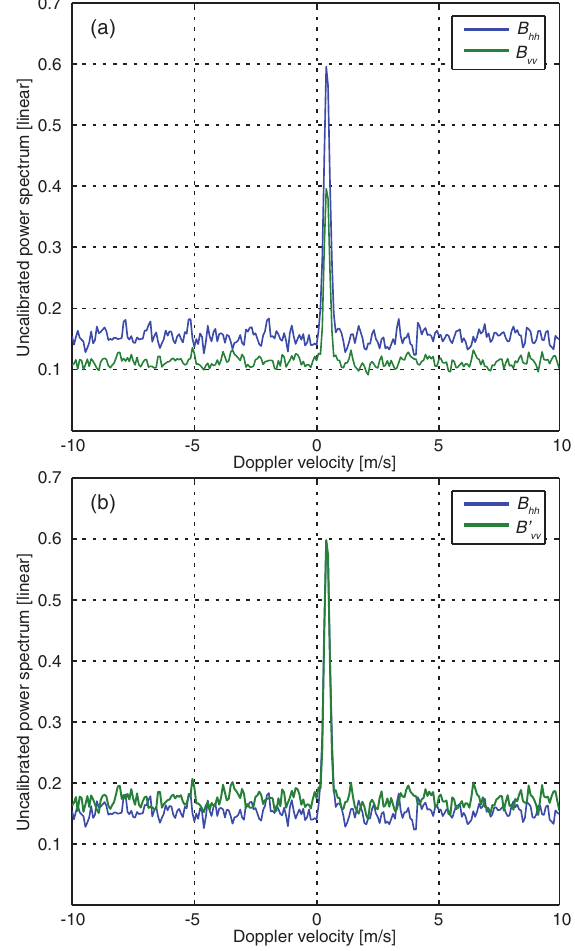
Figure 4. (a) Uncalibrated power spectra in the horizontal (blue line) and vertical (green line) channels. Displayed observations were obtained with the vertically pointed radar in light rain. (b) Un- calibrated power spectrum in the horizontal channel (blue line) and corrected power spectrum in the vertical channel (green line). The same data as in (a) are used. Mean noise levels of B hh and B (cid:48) vv , estimated using the Hildebrand–Sekhon algorithm, are 0.153 and 0.169, respectively. Note that this case was chosen to illustrate the correction. Due to low signal-to-noise ratios, such spectra were not used for the calculation of the coefficient K a (see Sect. 2.6).